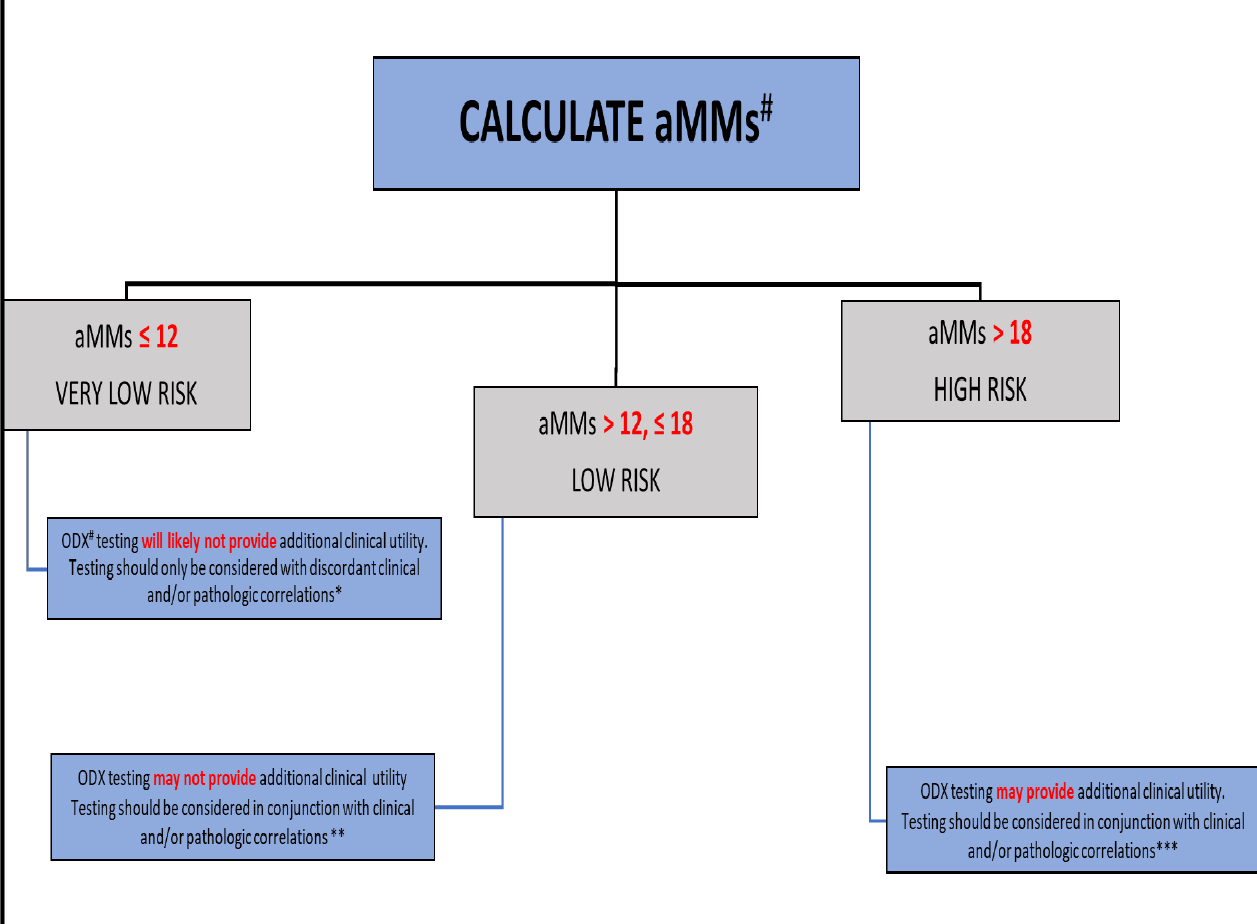
Figure 1. Rochester Modified Magee algorithm (RoMMa). # average Modified Magee score (aMMs); Oncotype DX ® score (ODX). * Patients with an aMMs ≤ 12 will likely have a <5% risk of breast cancer recurrence, comparable to patients with an ODX < 11. ** Patients with an aMMs between 12 and 18 may have a 5–8% risk of breast cancer recurrence, comparable to lower risk patients with an ODX between 11 and 25. *** Patients with an aMMs >18 may have a >10% risk of breast cancer recurrence, comparable to higher risk ODX